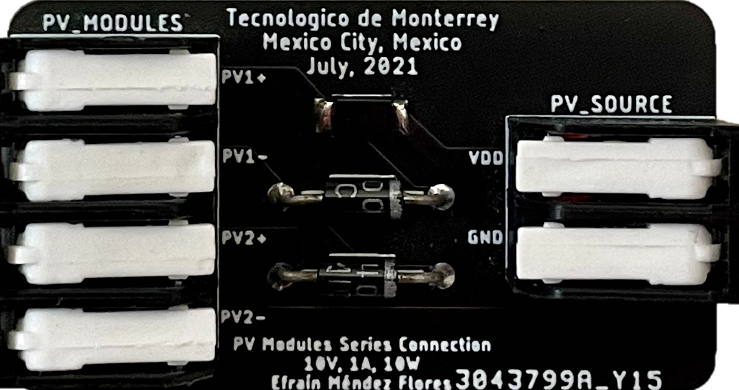
Figure 17. Manufactured experimental PCB design for PV supply integration.